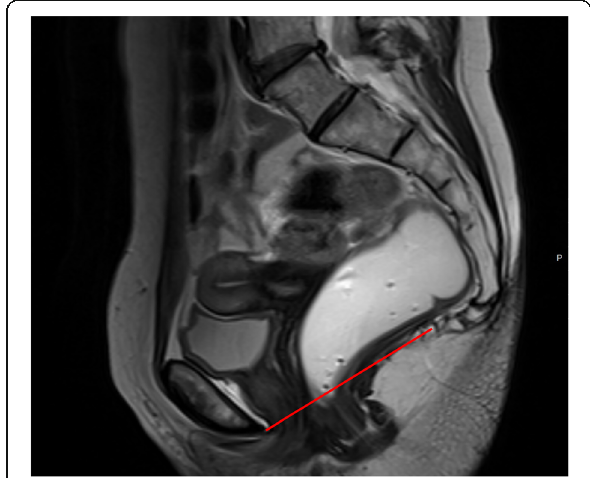
Fig. 5 Pubococcygeal line (PCL). Sagittal midline T2-TSE image with the PCL represented (red line) connecting the inferior border of the pubic symphysis and the last coccygeal joint